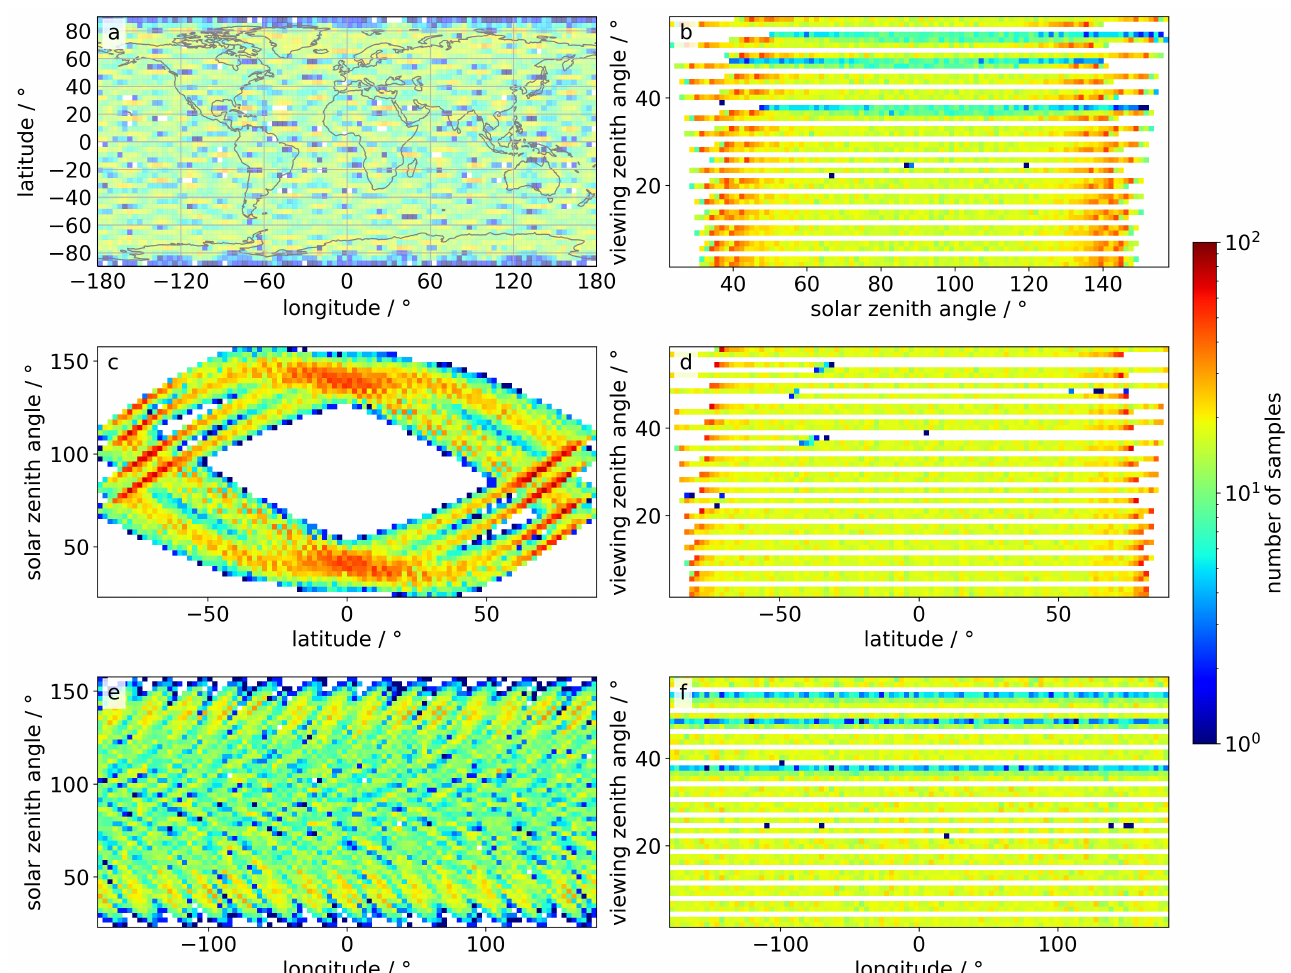
Figure 4. Distribution of the training dataset samples with respect to ( a ) latitude and longitude, ( b ) viewing zenith angle and solar zenith angle, ( c ) solar zenith angle and latitude, ( d ) viewing zenith angle and latitude, ( e ) solar zenith angle and longitude, and ( f ) viewing zenith angle and